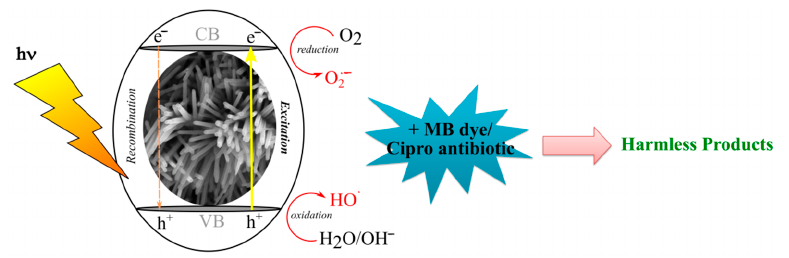
Figure 10. Schematic illustration of the degradation of organic contaminants in the presence of ZnO (PTVA) catalyst. Compared with the previously available reports (Table 1), the efficiency of our nanostructured ZnO-based photocatalyst synthesized by pulsed TVA is superior for the remediation of water polluted with organic dyes and pharmaceutical compounds. In ad- dition, our photocatalytic system is a valuable alternative to the existing approaches based on particles or powders, owing to the fact that the need for costly and time-consuming post-treatment steps to recover or to remove the suspended particles from the treated wa- ter bodies is avoided. As few reports are available for the photocatalytic degradation of organic contaminants from water by using ZnO films [87–90], tremendous attention has been paid to nanoparticles and powders. For example, films composed of ZnO-porous nanosheets have been synthesized via a hydrothermal approach directly on Zn foil, with improved photocatalytic activity in the degradation of Rhodamine B under UV light irra- diation, by Wang and co-workers [88]. Islam et al. assessed the photocatalytic activity of nanostructured ZnO film prepared by a sol–gel dip-coating technique through the decom- position of MB dye [87]. Similarly, the porous ZnO thin coatings prepared by a sol–gel process have been found to be an effective catalyst for the decomposition of chemical waste, such as phenol, chlorophenol, naphthalene and anthracene, to CO 2 [89]. Photocata- lytic activity of ZnO thin films grown by metal–organic chemical-vapour deposition was studied by measuring the photoinduced decolouration of Orange II dye solution [90]. To our best knowledge, this is the first study in which TVA working in a pulsed mode (PTVA) is employed to deposit Zn thin film, and flower-like, nanostructured ZnO (PTVA) coating was used for the successful treatment of ciprofloxacin from water under UV irradiation. Preliminary results indicate that ZnO (PTVA) coating shows very good photocata- lytic activity and stability for water splitting under sunlight irradiation. The photo-elec- trochemical measurements performed in a conventional three-electrode electrochemical- cell setup with aqueous electrolyte solution (0.1 M NaOH), under standard solar-illumi- nation conditions (AM 1.5 G, 100 mW/cm 2 ), reveal that the photocurrent density reaches a value up to 1.5 mA/cm 2 . The photo-electrochemical response for water splitting is a sub- ject of further experimental work, which will be reported on in a separate paper.